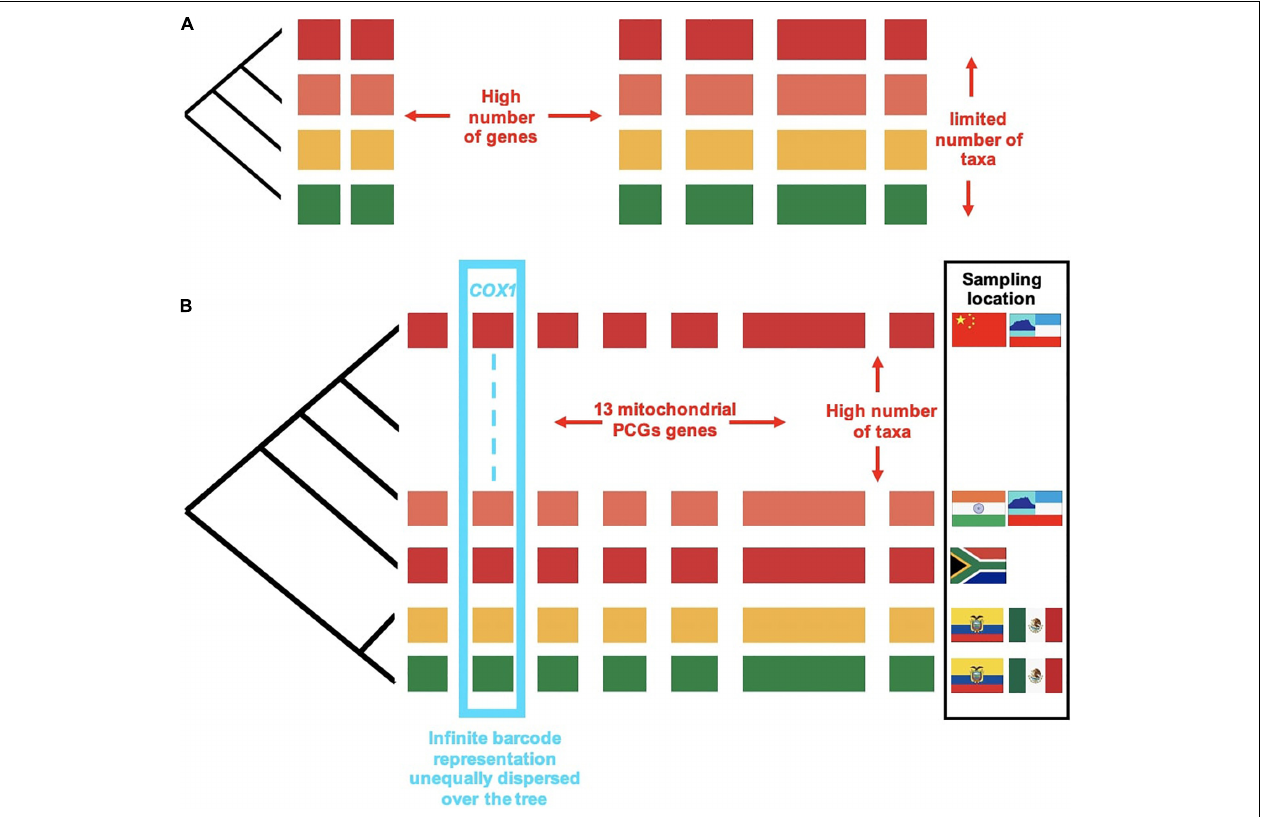
FIGURE 4 | The trade-off between number of lineages and number of genes: (A) A set of taxa chosen for taxonomic purposes and sequenced for a large number of genes, e.g., nuclear orthologs from whole-genome or transcriptome sequencing. (B) The addition of site-based data for full mitogenomes resulting in 13 protein coding genes (PCGs) obtained by genome skimming, and the much larger number of taxa sequenced for the cox1 gene from metabarcoding. Colored blocks represent the individual genes sampled. Different colors represent the lineages sampled. Designing a sampling regime for phylogenetics is necessarily a balancing act between number of genes (blocks) and number of lineages (colors). The availability of cox1 metabarcodes represented in discontinuous lines (cyan) dwarfs all other data types.